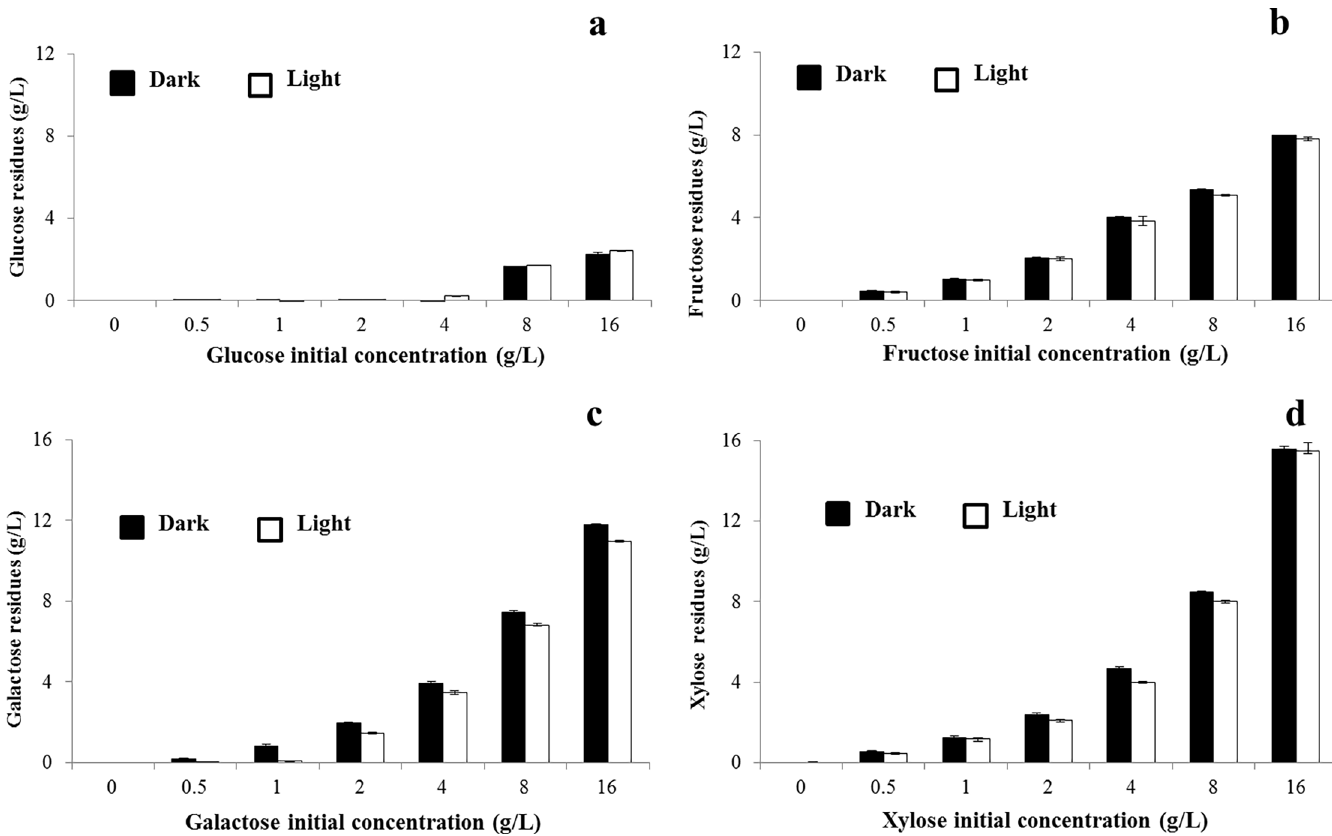
Fig 6. Residual monosaccharide after 7 days cultivation of Chlorella sorokiniana UTEX 1230. Residual monosaccharides (final concentration at 7 days) as measured by the dinitrosalicylic acid method and calculated based on a standard curve. a, b, c and d show remaining monosaccharide from glucose-, fructose-, galactose- and xylose-supplemented media, respectively. Data shown as mean +/-SD, n = 3. Black bar: dark conditions; white bar: light conditions.